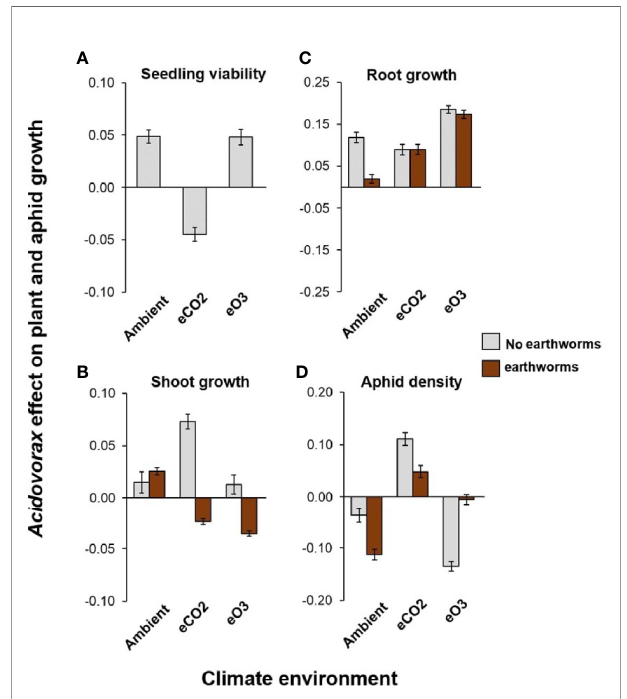
FIGURE 2 | Effect of A. radicis inoculation from paired analysis. Data shows the log-response of plant and aphid growth traits comparing plants that were treated with A. radicis with one treated with a control solution, for (A) seedling viability (early shoot growth), (B) shoot growth, (C) root growth, and (D) aphid density. Error bars show the variance around this ratio. N = 474